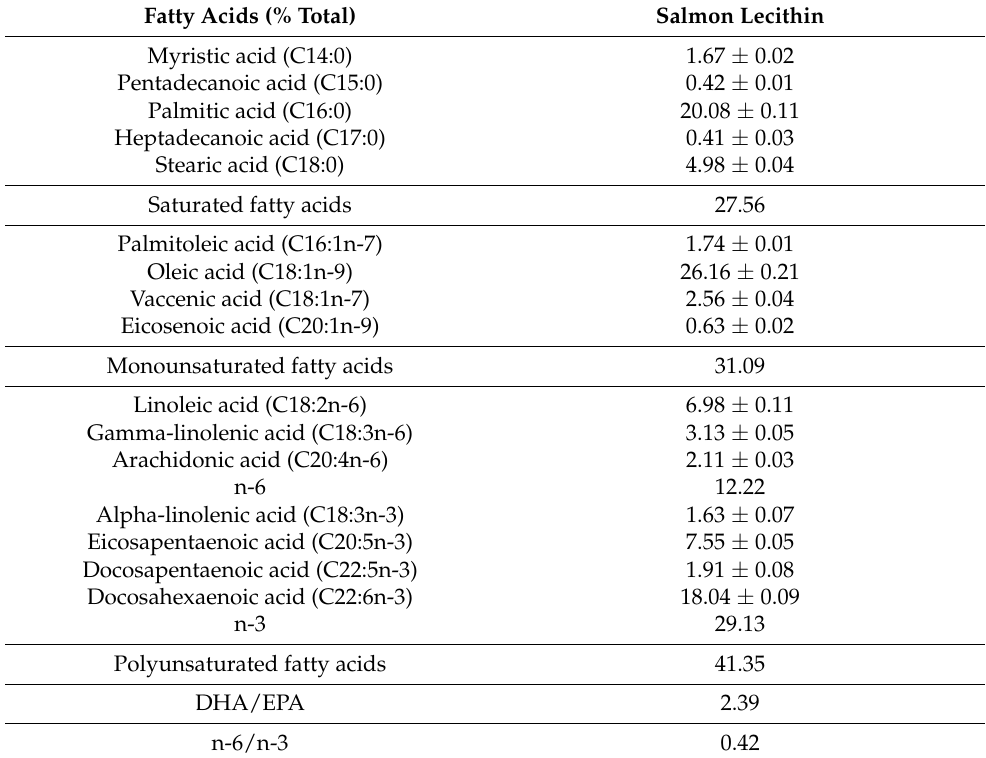
Table 1. Fatty acid composition of salmon lecithin.